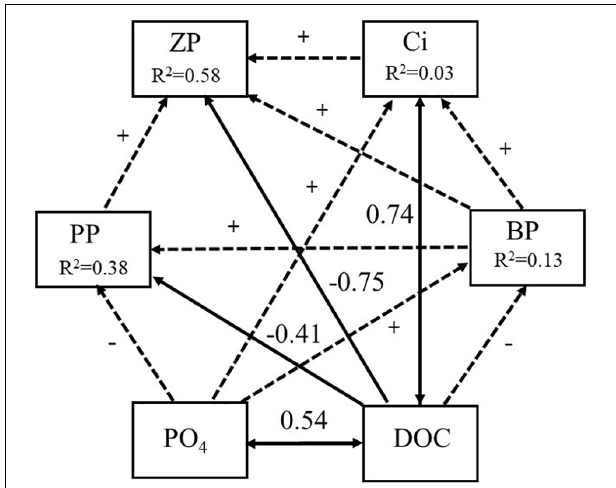
FIGURE 9 | Path diagram for structural equation model relating phosphate (PO 4 ) and dissolved organic carbon (DOC) to primary production (PP), bacterial production (BA), ciliate biomass (Ci) and zooplankton biomass (ZP) during the second part of the experiment (Day 17 and Day 28). Squared multiple correlation (R 2 ) in boxes indicate the percent of variance explained through the model. The numbers next to arrow are standardized regression coefficients of the SEM model. Solid black arrows represent significant path ( p < 0.05) while dash arrows non-significant paths ( p > 0.05). Plus or minus indicate relationship between variables.